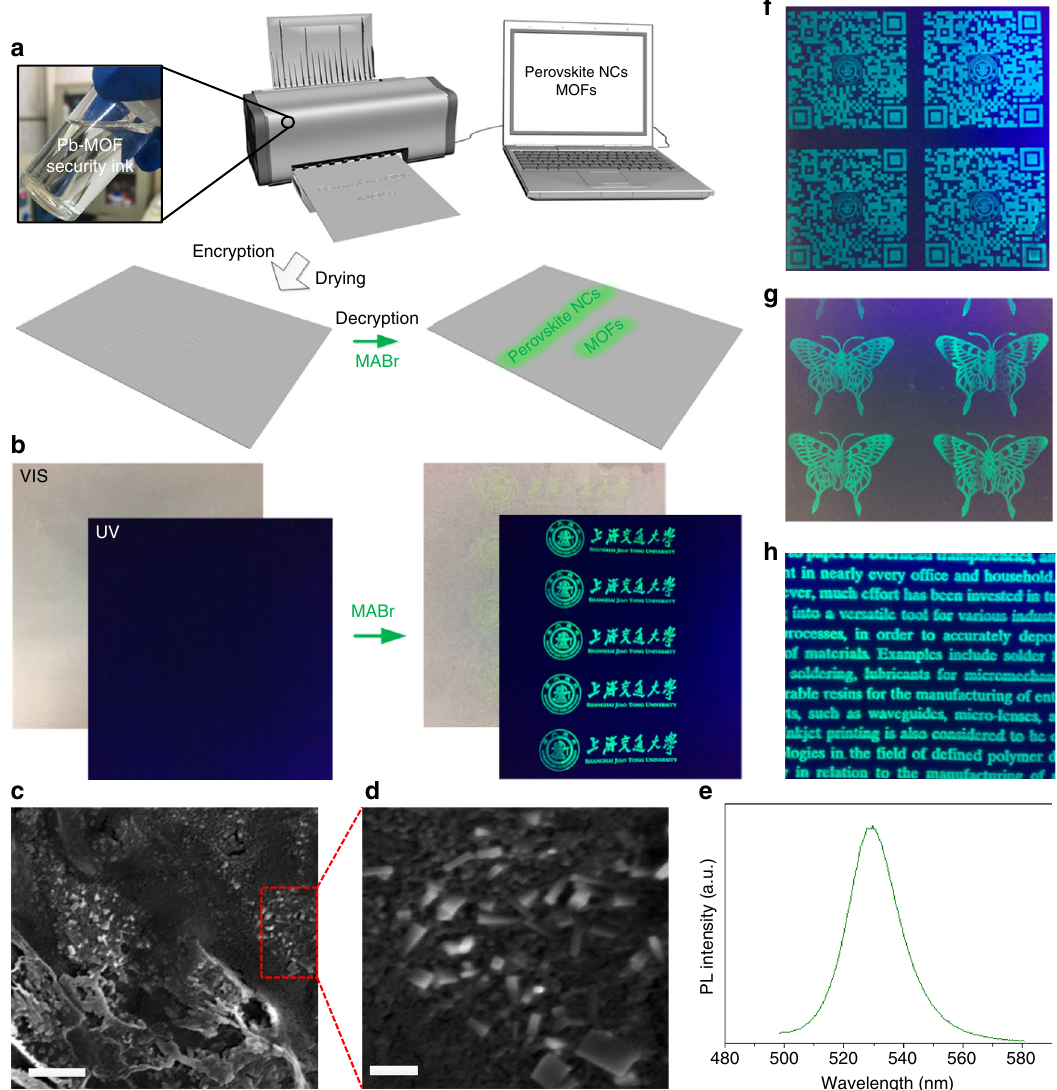
Fig. 3 Luminescent perovskite NC patterns from a Pb-MOF via inkjet printing. a Schematic illustrations of the patterning, information encryption, and decryption process of the perovskite NCs-MOF platform. b Digital images of the printed logo of Shanghai Jiao Tong University on a commercial parchment paper before and after MABr loading under ambient light and a 365 nm UV lamp. c , d SEM images of the parchment substrates with Pb-MOF pattern. Scale bar, 1 μ m ( c ); 200 nm ( d ). e PL spectrum of the MAPbBr 3 NCs@Pb-MOF pattern on parchment substrate. f – h Printed complicated patterns: QR code, butter fl y, and characters,